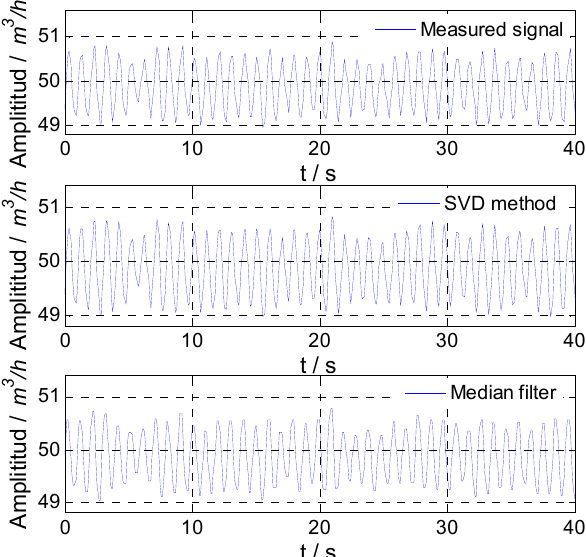
Figure 12. Frequency spectrums of measured result for experiment Nos. 2 and 3. For experiment Nos. 2 and 3, the measured signals and signals obtained by the median filter and SVD method are shown in Figures 13 and 14. The sinusoidal fluctuation with a single frequency and the flow fluctuation of the facility itself obtained by the SVD method are shown in Figures 15 and 16. It could be found that the SVD method could extract the sinusoidal fluctuation signal with a single frequency and the flow fluctuation signal of the facility itself with eliminating noise at the same time. The experimental results of flow fluctuation are given in Table 7.